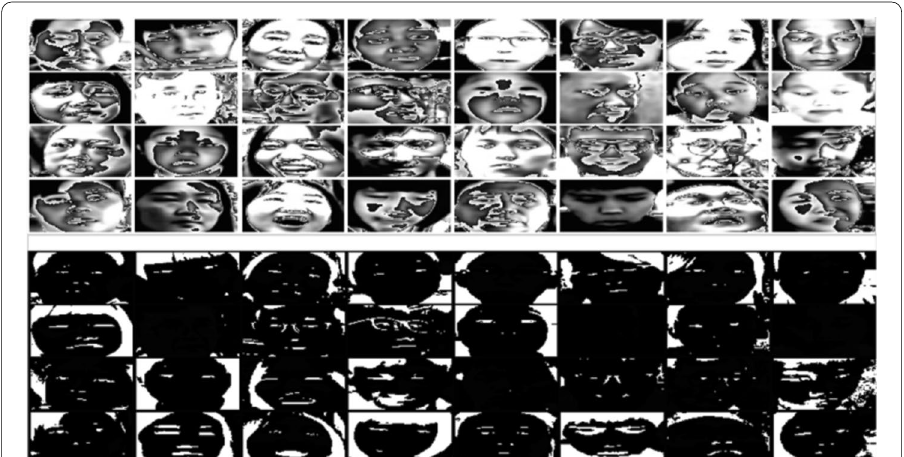
Fig. 13 Original image and generated image from its features